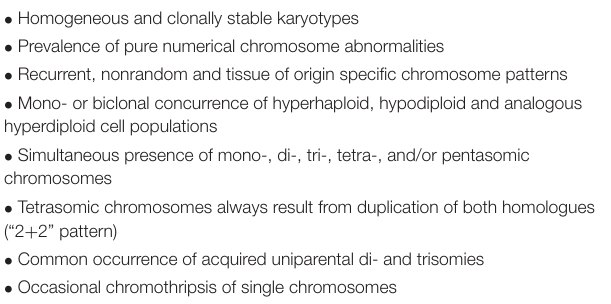
TABLE 1 | Common features of malignancies with chromosome counts in the uneven ploidy